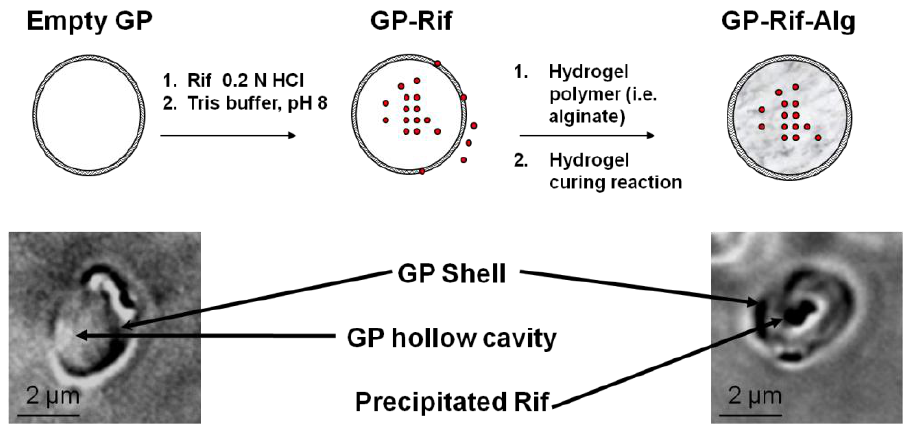
Figure 1. Schematic representation of Rif (red circles) loading into GPs and sealing with a hydrogel. Microscope brightfield images of empty GPs and GP-Rif